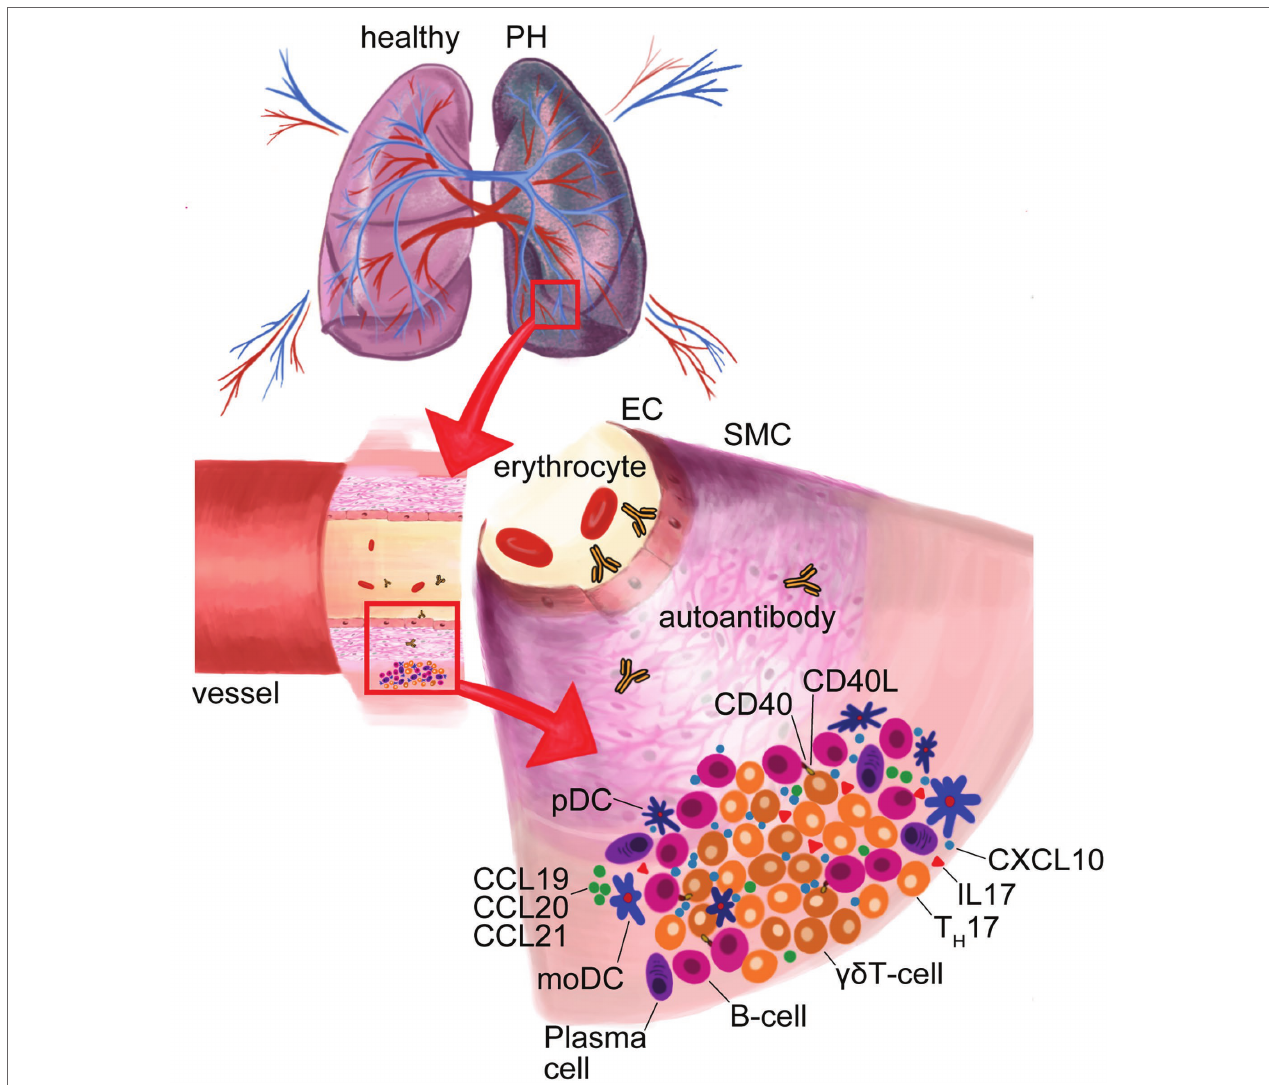
FIGURE 4 | Formation of tertiary lymphoid organs (TLOs) in lungs of pulmonary hypertension (PH). Dendritic cell (DC)-attracting chemokines C-C-chemokine- ligand-20 (CCL20), CCL19 and CCL21 in TLOs cause DC accumulation. Activated plasmacytoid (pDCs) secrete C-X-C motif chemokine ligand 10 (CXCL10) that recruits γδ T-cells, which, in turn, activate B-cells via CD40-ligand (CD40L) and, thus, support the formation of autoantibodies by plasma cells. MoDCs effect T H 17 differentiation that produce the proinflammatory interleukin-17 (IL-17). Endothelial cell (EC); smooth muscle cell